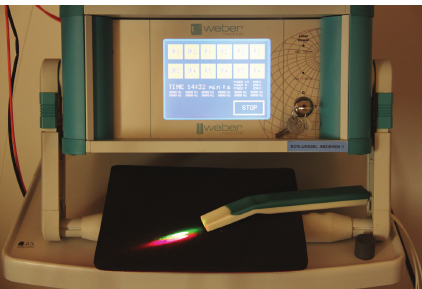
Figure 1: Weberneedle Endolaser (identical systems are available at the Medical University of Graz and the St. Mary Emergency Hospital for Children, Iasi). The following wavelengths were used for sublingual laser treatment: 630 nm (red), 536 nm (green), and 405 nm (violet).